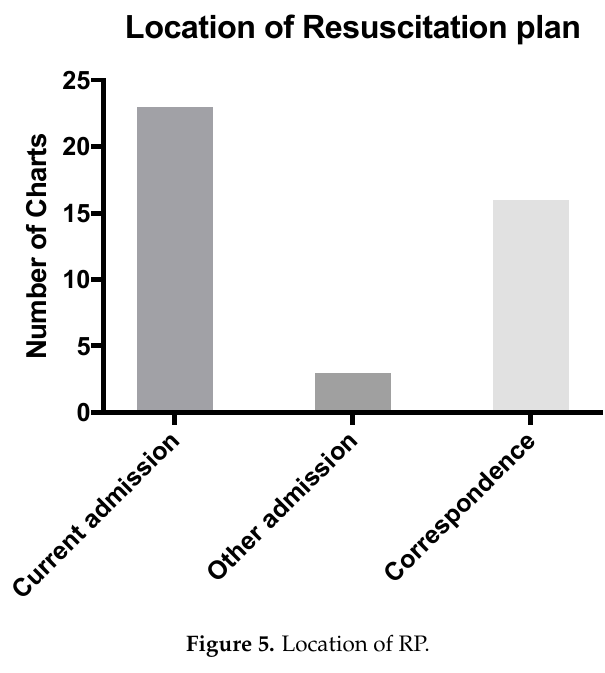
Figure 5. Location of RP.